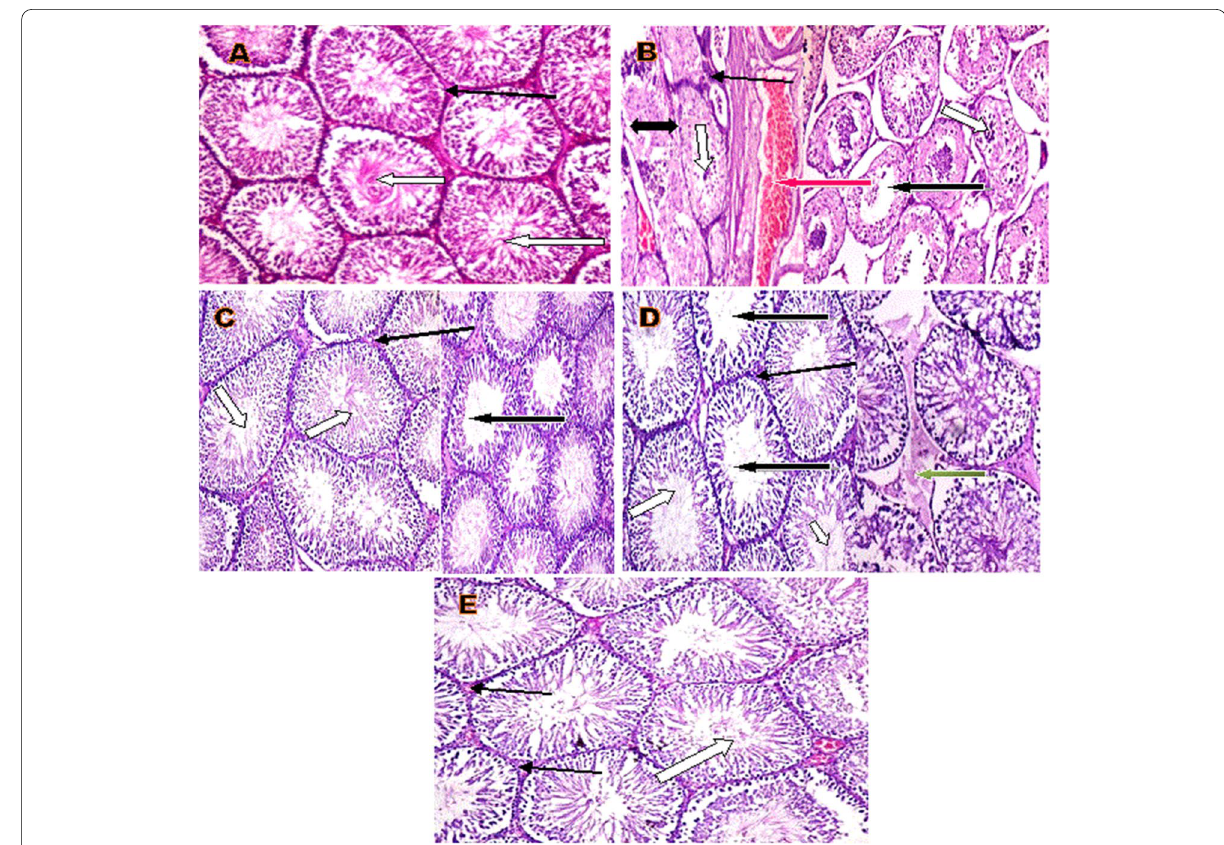
Plate 1 A Effect of treatment with zinc sulfate and N‑acetylcysteine on histology of the testis in phthalate‑treated male Wistar rats. A Photomicrograph of testicular sections from the control group: seminiferous tubules with the presence of spermatozoa (white arrow). The interstitial spaces and Leydig cells (slender arrow). B Photomicrograph of a testicular section from the PHT group; very poor testicular architecture (spaned black), fibrotic and atrophic seminiferous tubules with and vacuolation (white arrow), seminiferous tubules with degeneration and maturation arrest (black arrow), interstitial spaces (slender arrow), moderately congested tunica albugenia (red cells). C Photomicrograph of a testicular section from the PHT ZnSO 4 ‑treated group; seminiferous tubules with the presence of spermatozoa (white arrow). Seminiferous tubules show maturation arrest + (black arrow), interstitial spaces with Leydig cells (slender arrow). D Photomicrograph of a testicular tissue treated with PHT tubules with the presence of spermatozoa (white arrow). Seminiferous tubules with maturation arrest (black arrow). Interstitial spaces (slender arrow), congestion (green arrow). E Photomicrograph of a testicular section from the group treated with a combination of PHT seminiferous tubules with the presence of spermatozoa (white arrow). Interstitial spaces with normal Leydig cells (slender